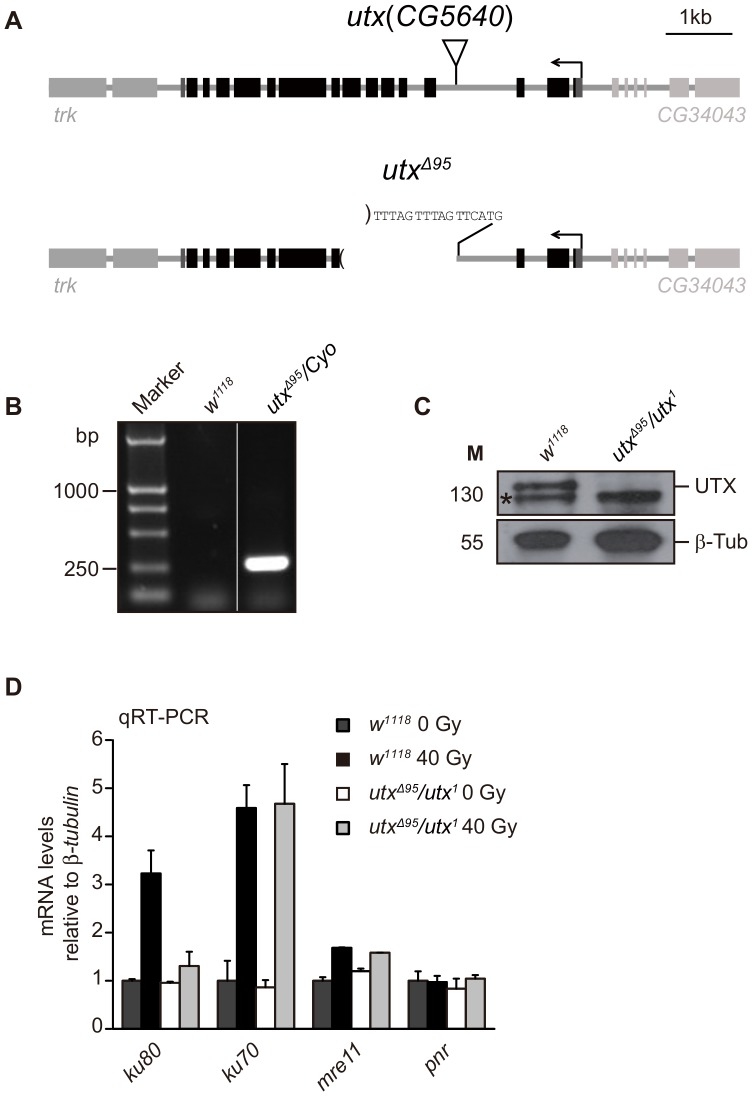
UTX is required for the expression of ku80 following IR exposure in Drosophila.
(A) Schematic illustration of the gene structure of wild type utx and a utx mutant allele (utxΔ95) generated via the imprecise excision of a P-element insertion. (B, C) Genomic PCR (B) and Western blot (C) analyses to verify the utxΔ95 genotype. (B) An approximately 250-bp band is detected in adult flies with a utxΔ95/Cyo genotype, but absent from the w1118 genotype. For details, please see the Materials and Methods section. (C) An approximately 130-kDa band indicated by an arrow in w1118 flies was not detected in the utxΔ95/utx1 third instar larvae. A non-specific band is indicated by an asterisk, and β-Tubulin (β-Tub) was used as a loading control. (D) qRT-PCR analysis of mRNA expression for the indicated genes before and after IR exposure in the w
1118 and utxΔ95/utx1 third instar larvae. The relative expression levels are normalized to β-tubulin levels. Note that ku80 is the only gene that requires utx for its expression.